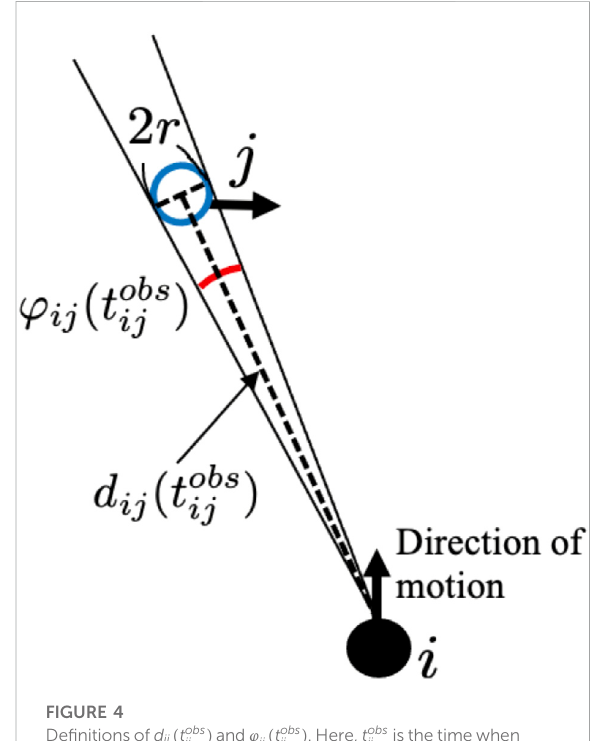
FIGURE 4 De fi nitions of d ij ( t obs ij ) and φ ij ( t obs ij ) . Here, t obs ij isthetime when agent j is detected by agent i for the latest time.